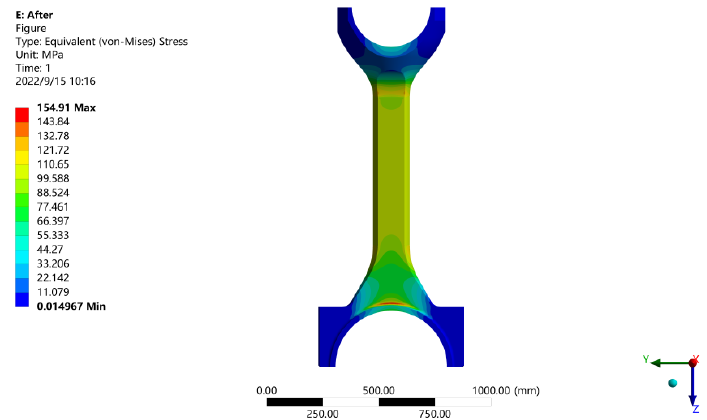
Figure 19. Stress diagram of optimized connecting rod body.